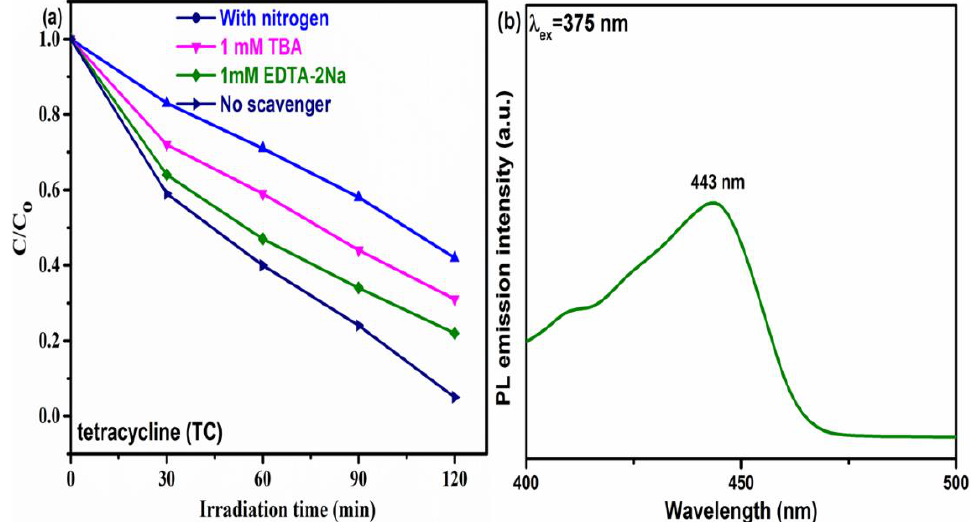
Figure 8. ( a ) Photogenerated reactive species trapped by dissimilar scavengers through degradation of TC on 3APMZ. ( b ) The 7-hydroxycoumarin PL emission intensity was observed at 443 nm under the irradiance of visible light.